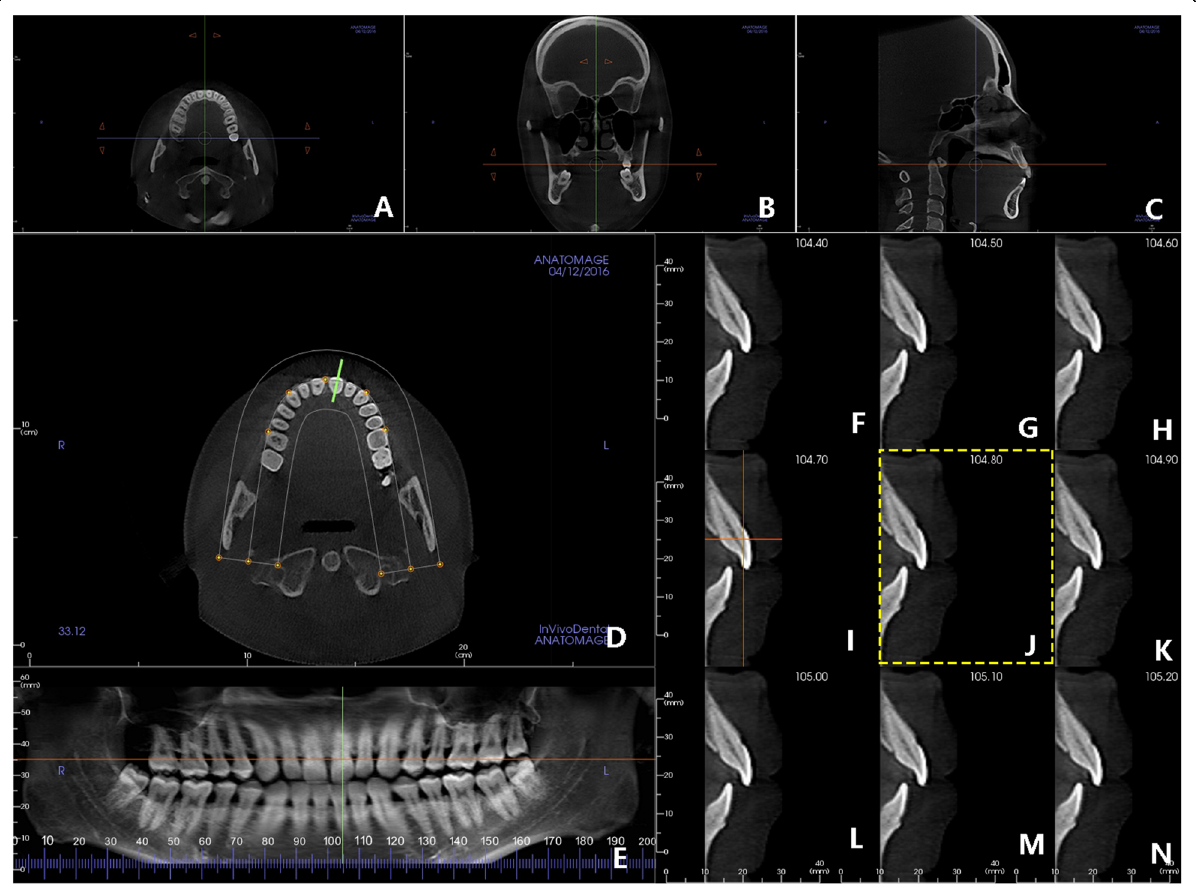
Fig. 3 Measuring image capture. The natural position of the head is adjusted in three dimensions. a The horizontal view. b The coronal view. c The sagittal view. A bunch of cutting lines (green) was vertical to incisor labial surface ( d ) and located at the central coronal view ( e ). The median sagittal views were established with nine layers ( f – n ), interval 0.10 mm, and the middle one was the measuring image ( j